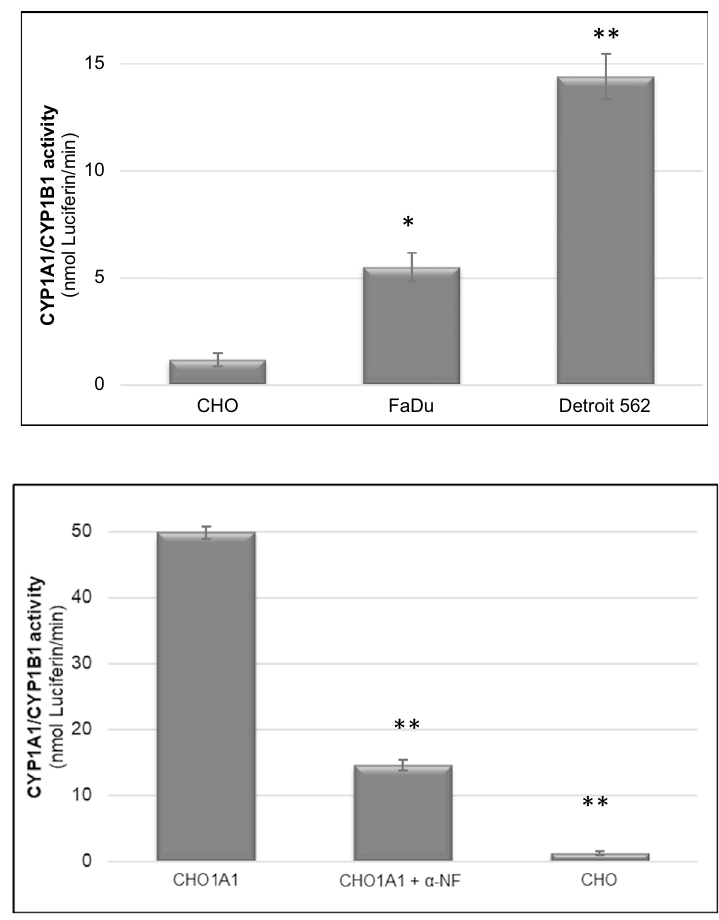
Figure 4. (A) CYP1A1/CYP1B1 activity in CHO, and the HNC cell lines FaDu and Detroit-562. [***P ≤ 0.001, **P ≤ 0.01 relatively to CHO cell line]. ( B ) CYP1A1/CYP1B1 activity in CHO1A1 and CHO cell lines in the absence or presence of 1 µM of the inhibitor α-NF and CHO. [***P ≤ 0.001 relatively to